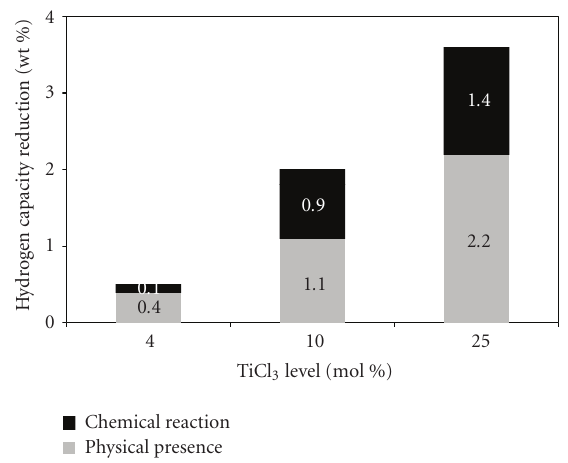
Figure 3: Hydrogen capacity reduction of the LiBH 4 /CaH 2 mixture with 4, 10, and 25mol% of TiCl 3